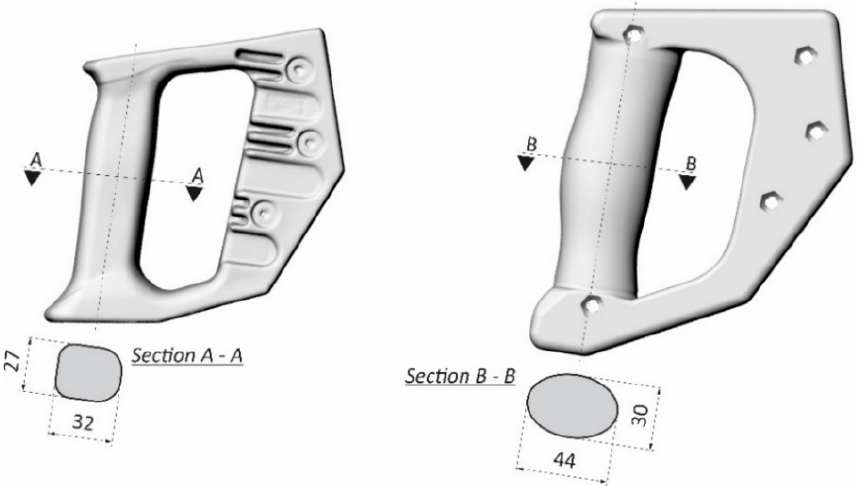
Figure 1. Original manufacturer’s saw handle ( left ) and modified saw using an optimally shaped handle ( right ).